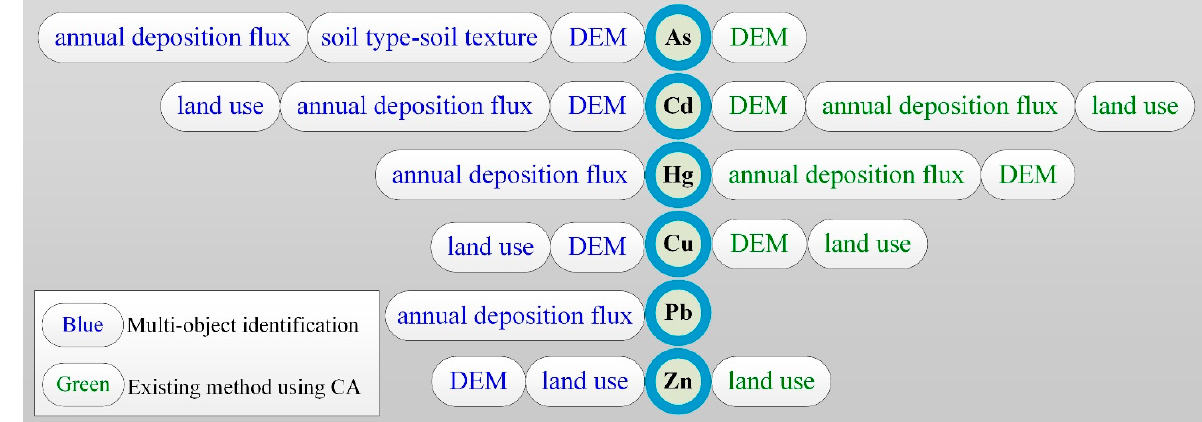
Figure 7. The identification results for multi-object identification and CA methods.